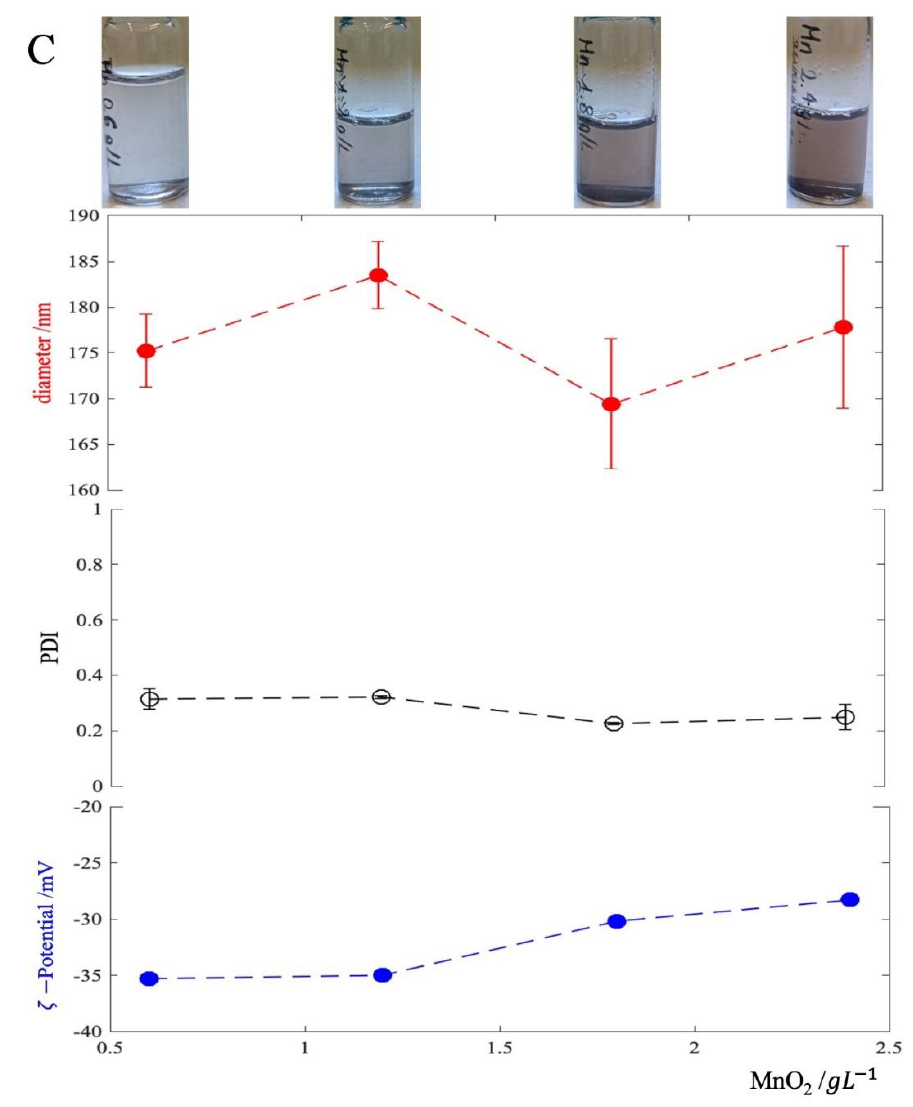
Figure 3. ( A ) Size distributions and ( B ) ζ -potential values of MnO 2 samples at different concen- trations: 0.6 ( a ), 1.2 ( b ), 1.8 ( c ), and 2.4 ( d ) g L − 1 . ( C ) Average hydrodynamic diameter (red full dots), PDI (empty black dots), and ζ -potential values (blue full dots) of MnO 2 samples at different MnO 2 /water